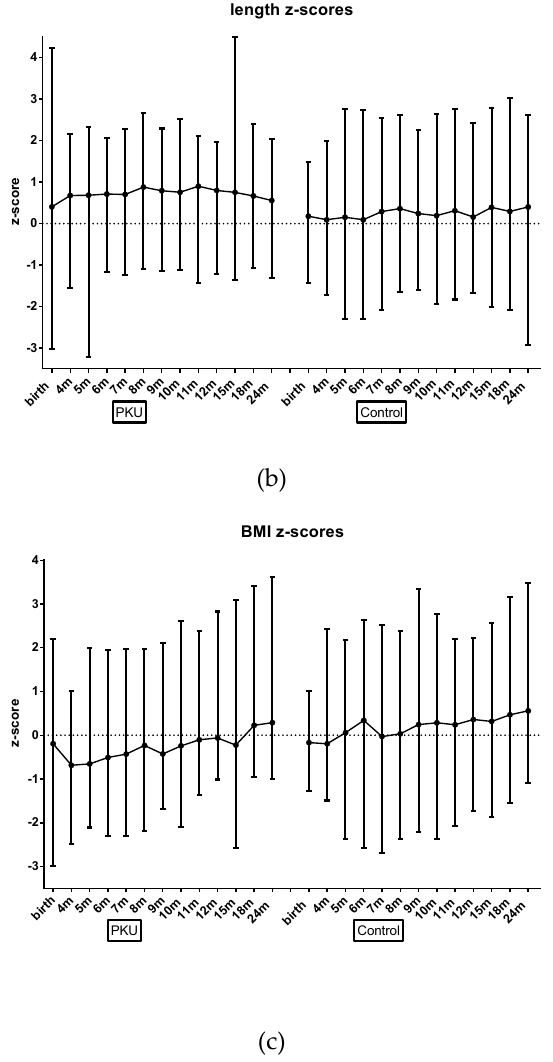
Figure 1. Mean weight, length and body mass index (BMI) z-scores for PKU and control groups by age. (a) Mean weight z-scores for PKU and control groups by age; (b) Mean length z-scores for PKU and control groups by age; ( c ) Mean BMI z-scores for PKU and control groups by age. Nutrients 2018 , 10 , x FOR PEER REVIEW